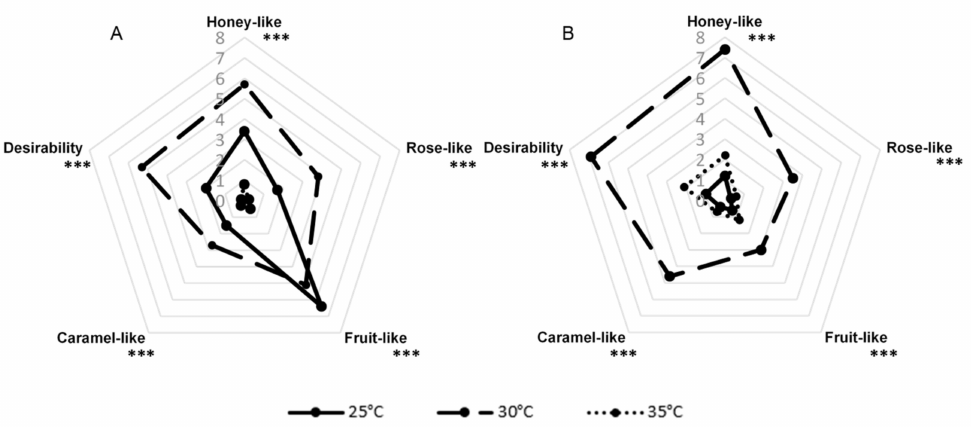
Figure 4. Sensory profiles of post-fermentation products from flask cultures with ( A ) sour whey and ( B ) buttermilk for various incubation temperatures. *** p <